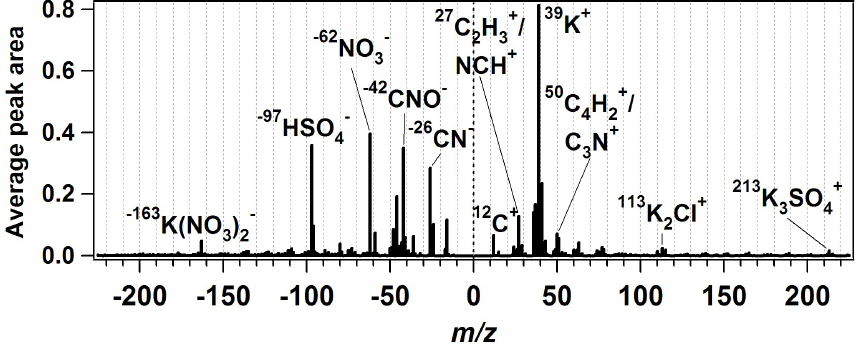
Fig. 4. A-ATOFMS average mass spectrum of 52 fresh biomass burning particles sampled during RF03 plume Period 1.